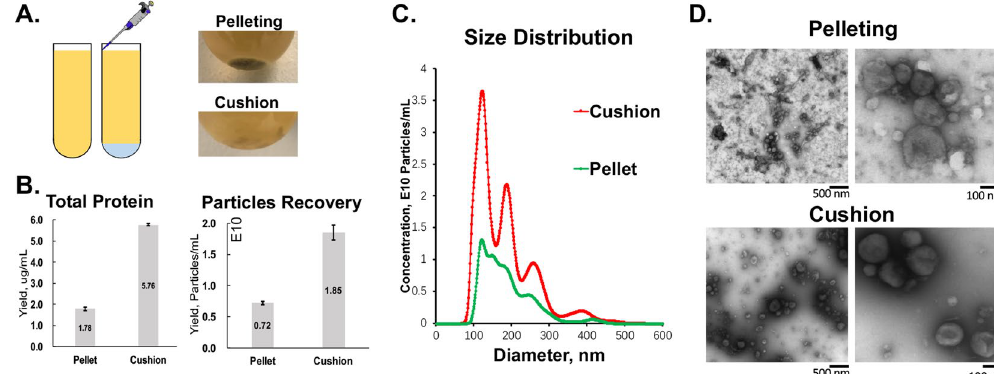
Figure 2. Characterization and comparison between ultracentrifugation with and without cushion for GDENs purification. ( A ) Schematic of cushion load to ultracentrifuge tube by slowly pipetting from side wall to the bottom and photo shows GDENs concentrated at the interception of cushion layer compare to the pellet pack firmly at the bottom. ( B ) Comparison of yield by total protein and particles standardized by volume of ginger juice isolated from. ( C ) Size distribution and particle concentration measured by NTA of GDENs purified from equal amount of ginger juice with and without cushion. ( D ) Negative staining TEM imaging showing the morphology of GDENs purified by pelleting and cushion